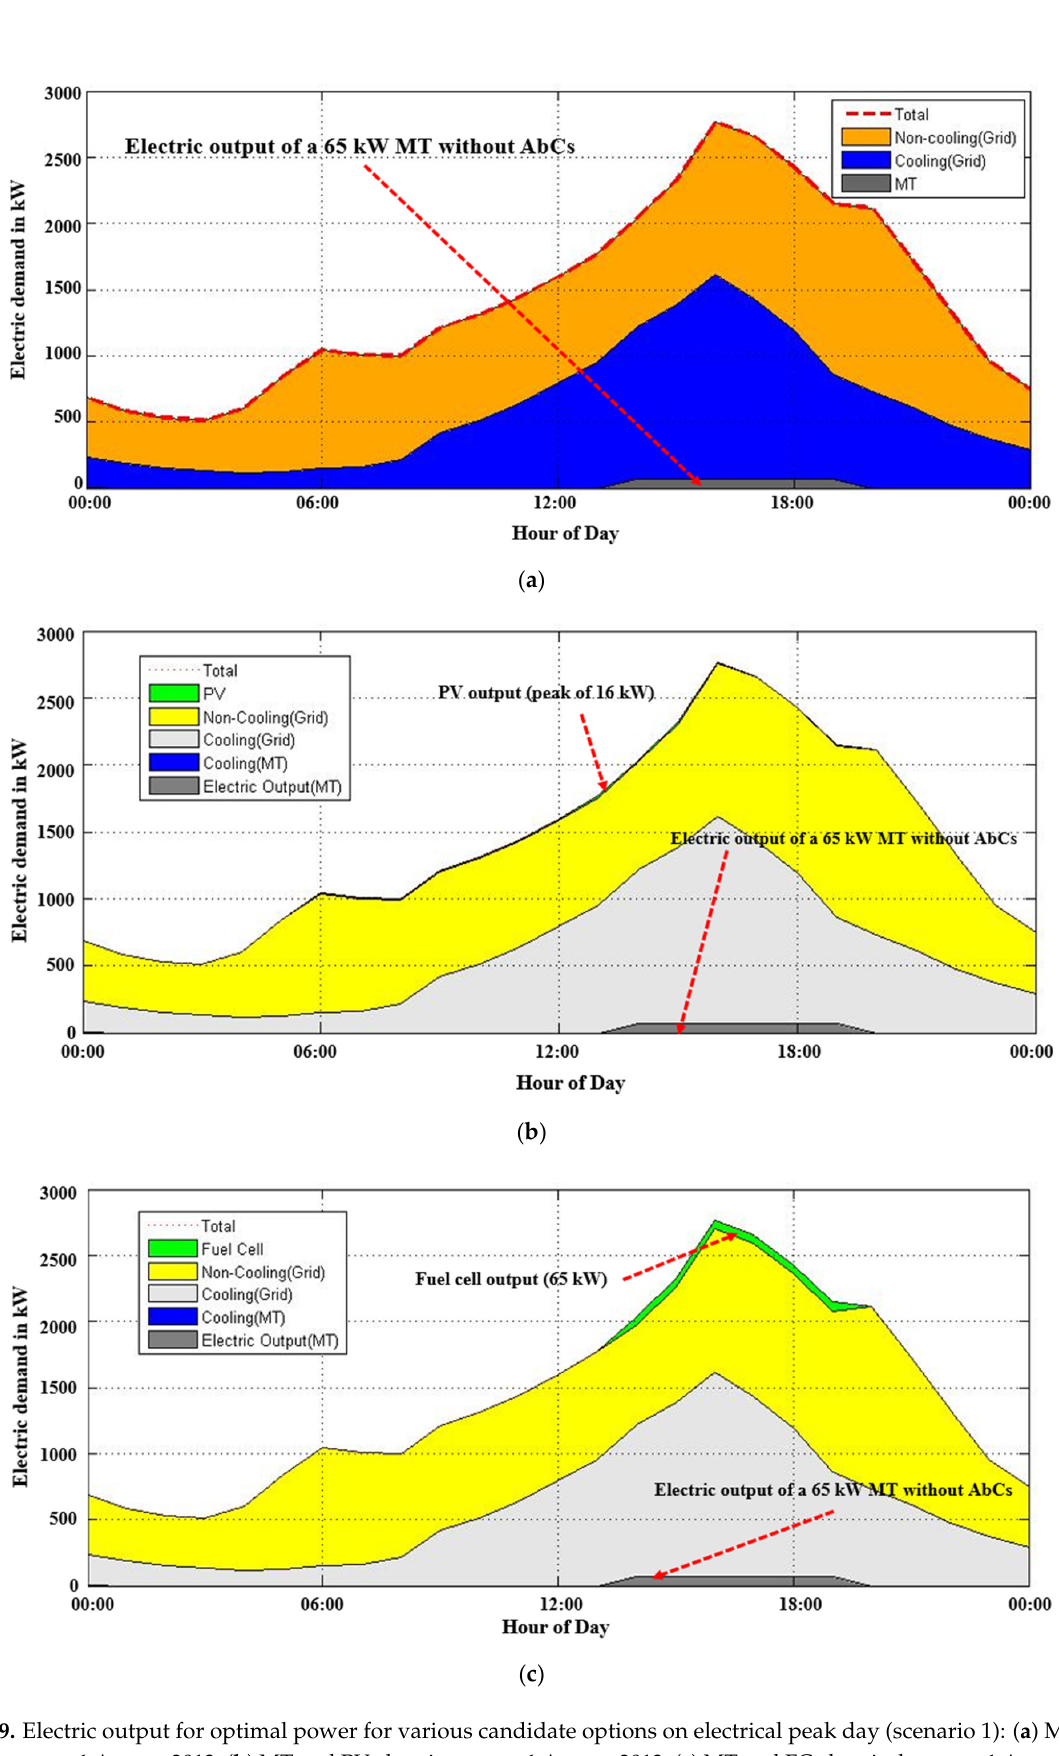
Figure 9. Electric output for optimal power for various candidate options on electrical peak day (scenario 1): ( a ) MT only electric output; 1 August 2013; ( b ) MT and PV electric output; 1 August 2013; ( c ) MT and FC electrical output; 1 August